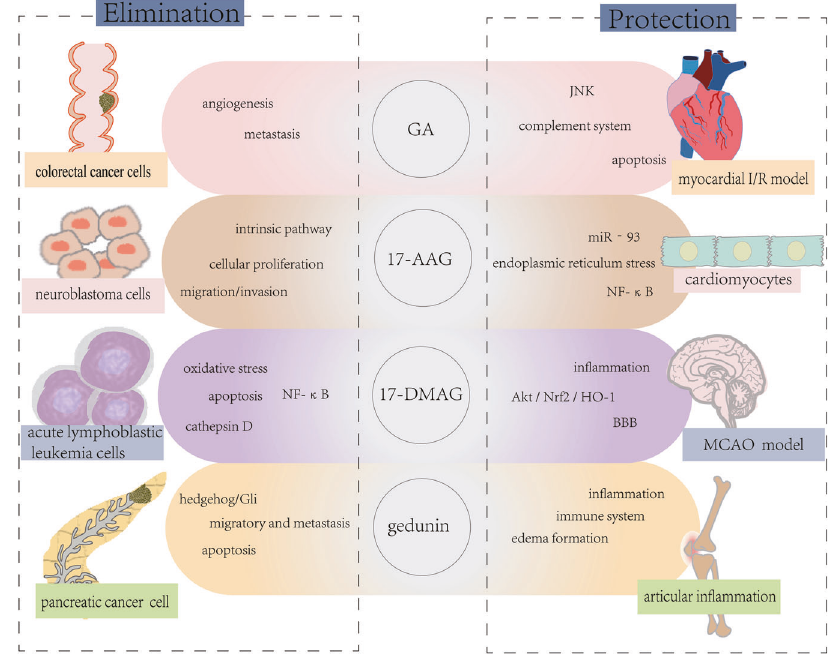
Fig. 2 HSP90 inhibitors exert therapeutic effects in various diseases. HSP90 inhibitors could simultaneously apply to cancer, myocardial ischemia and other diseases. On the one hand, HSP90 inhibitors protect cardiomyocytes and neurons by reducing in fl ammation and relevant signaling pathways. On the other hand, inhibitors eliminate cancer cells by inducing